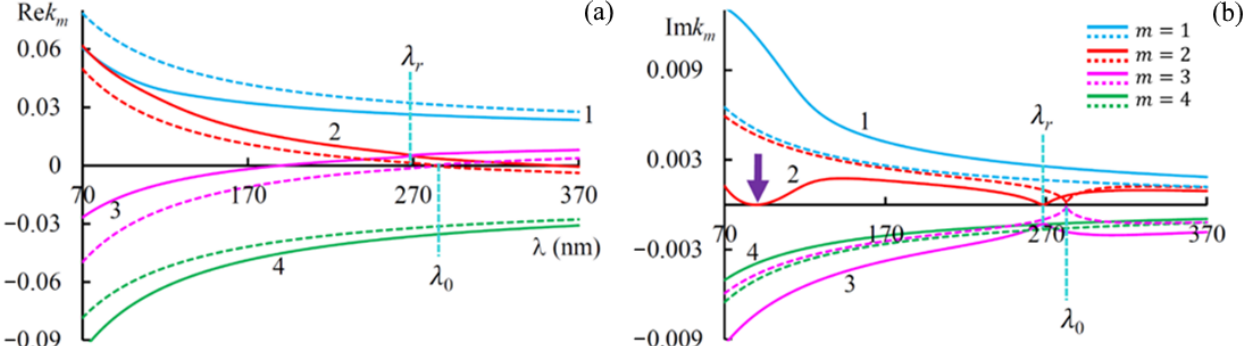
Figure 2. The dependences of Re k m ( a ) and Im k m ( b ) on the wavelength λ in the case of g = 0.3 (solid lines) and g = 0 (dashed lines). The imaginary parts of the principal values of local dielectric tensors are as follows: Im𝜀 1 = 0.2 , Im𝜀 2 = 0 .